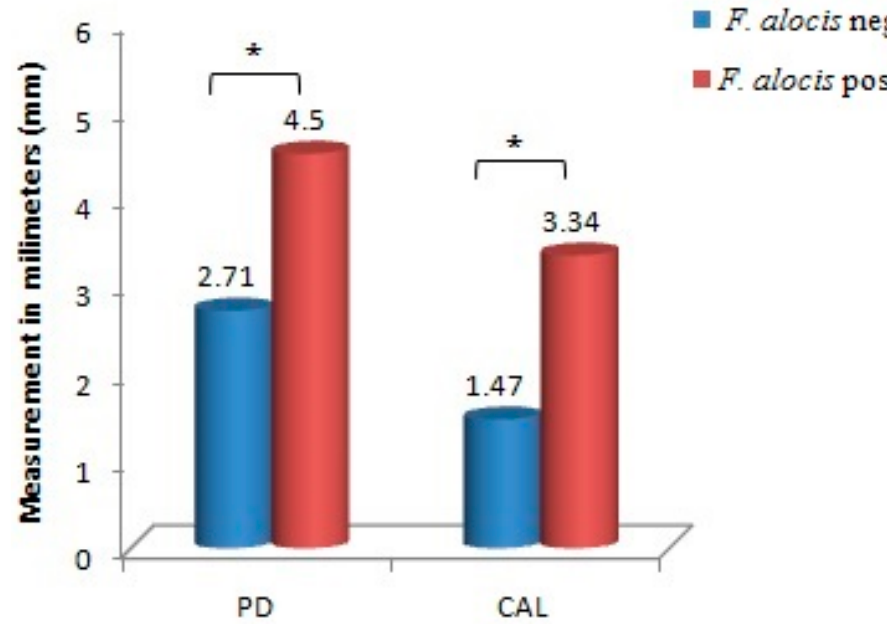
Figure 3. Correlation of pocket depth (PD) and clinical attachment loss (CAL) with the presence or absence of F. alocis . * p < 0.05 = significant. Table 2. Comparison of the two study groups with respect to the occurrence of different bacterial Table 5. Correlation of HbA1c values with the presence or absence of F. alocis. species.